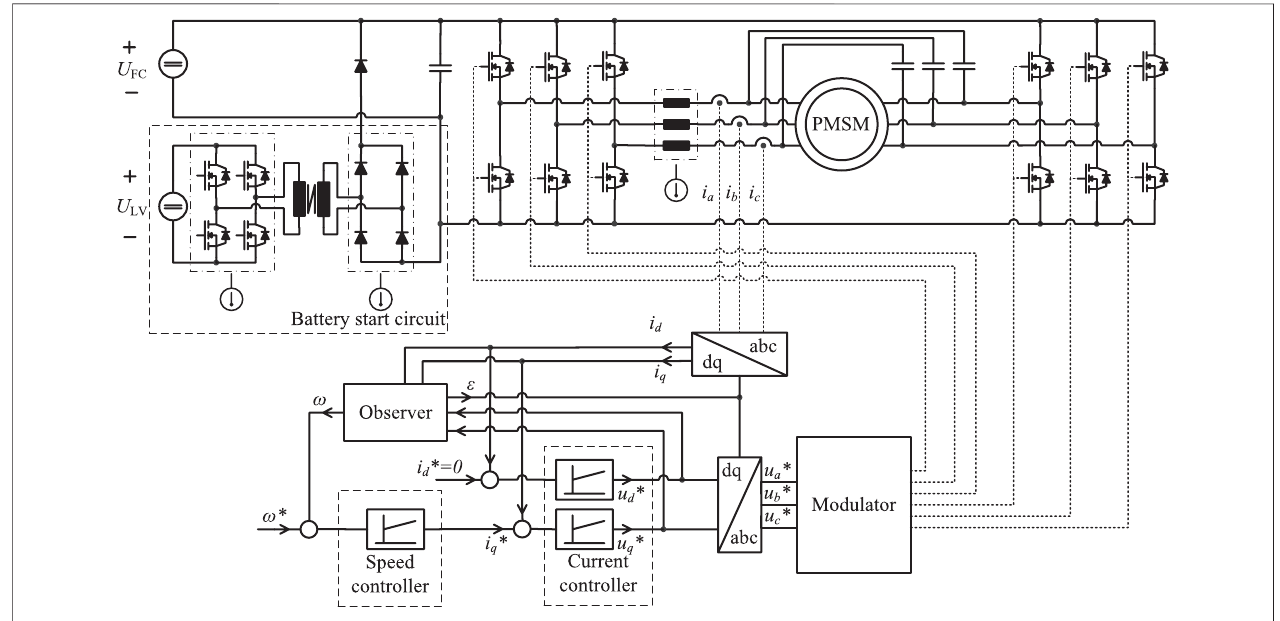
FIGURE 7 | Electrical circuit diagram of the novel high-speed turbo compressor system with integrated inverter, including sensors and control.